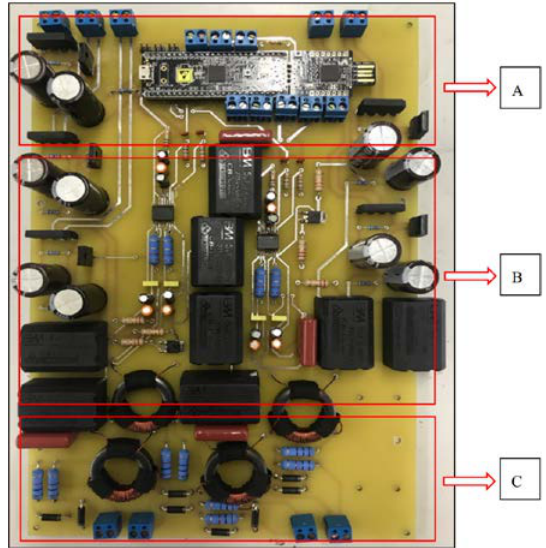
Figure 3. The three different frequency generator circuits of the system.